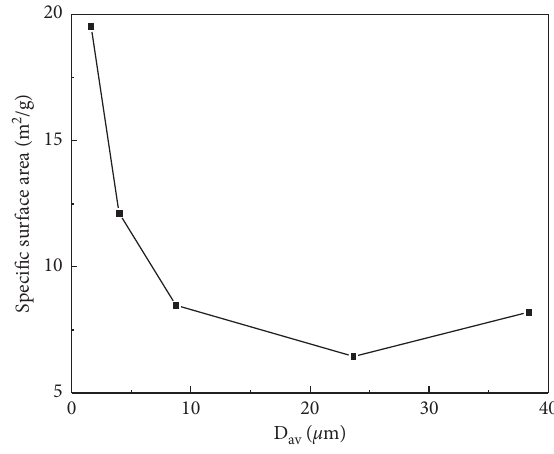
Figure 5: Relationship between average particle size and specific surface area.